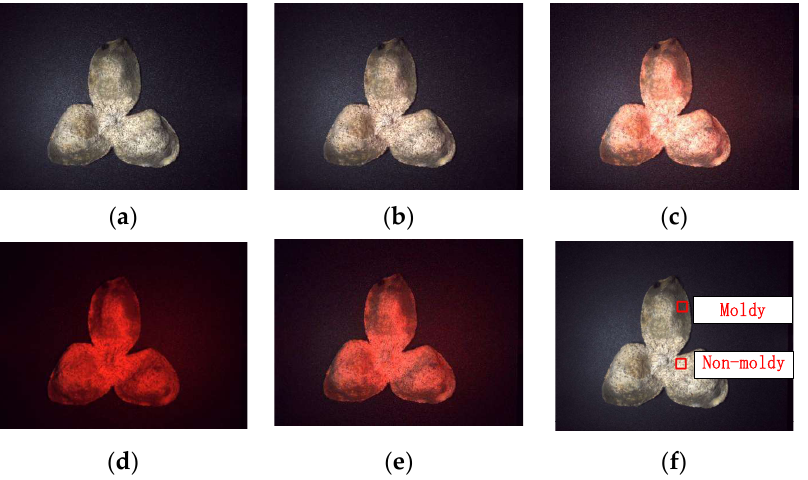
Figure 9. Various light sources of the PCRC moldy sample pictures. ( a ) Image under white light electric power 360 mW; ( b ) Image under white light electric power 360 mW and red light electric power 195 mW; ( c ) Image under white light electric power 360 mW and red light electric power 360 mW; ( d ) Image under red light electric power 360 mW; ( e ) Image under white light electric power 195 mW and red light electric power 360 mW; ( f ) The moldy area and non-moldy areas were dug in original image.